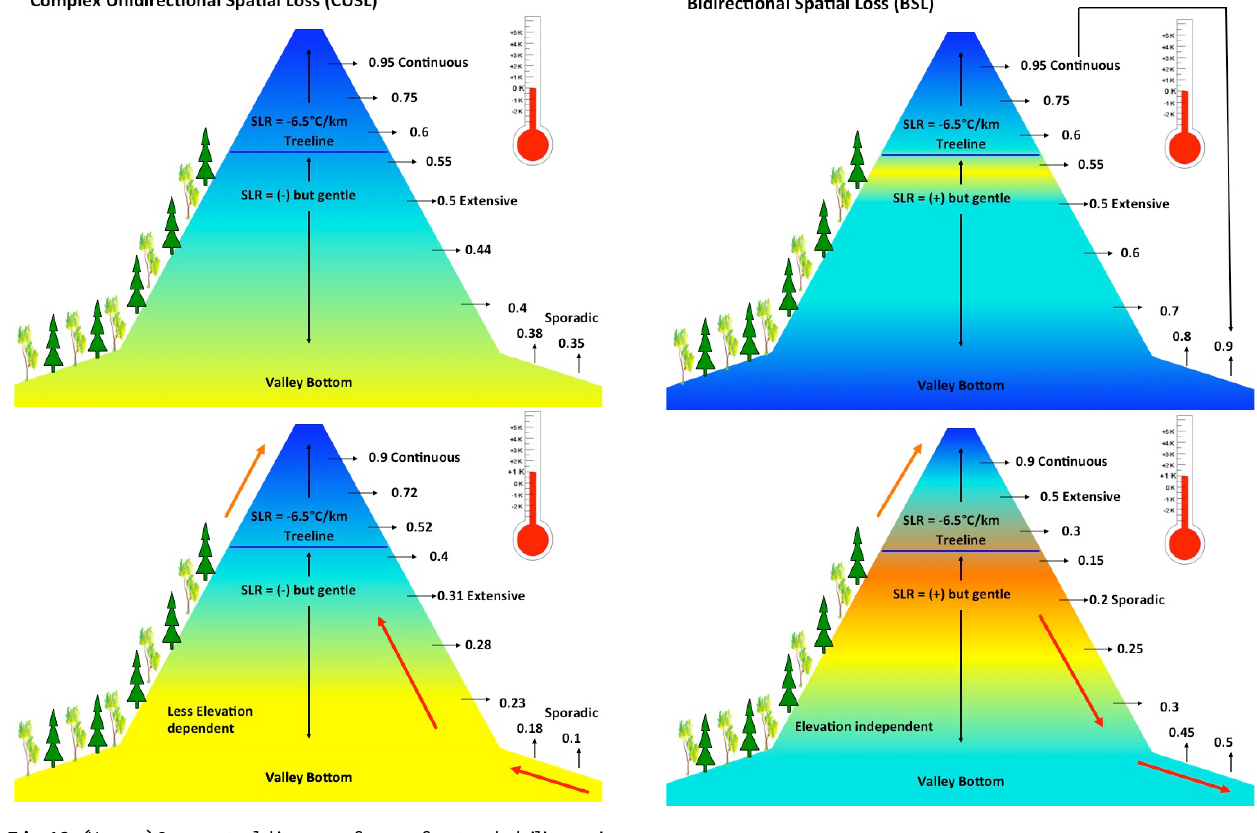
Fig. 14. (Upper) Conceptual diagram of permafrost probability vari- ation in an area susceptible to bidirectional spatial loss; (lower) equilibrium permafrost probabilities following a warming